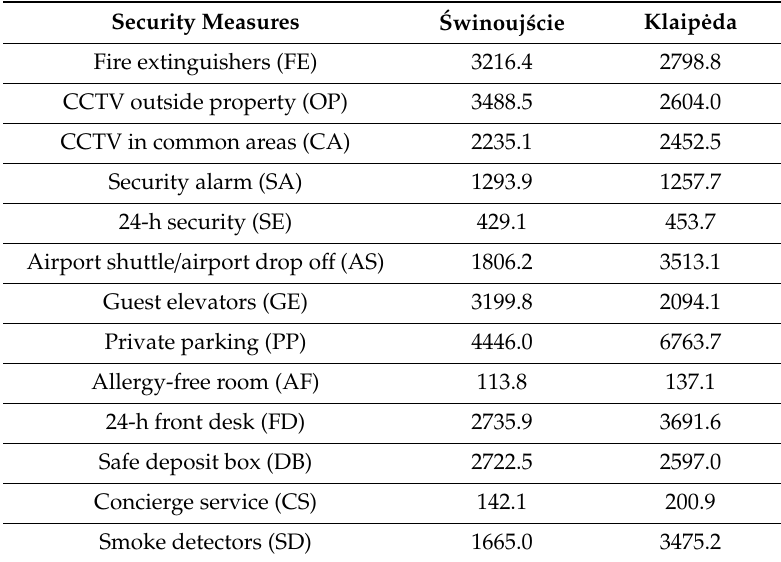
Table 4. Level of concentration of the security measures at the accommodation facilities as measured by the Herfindahl–Hirscham Index.